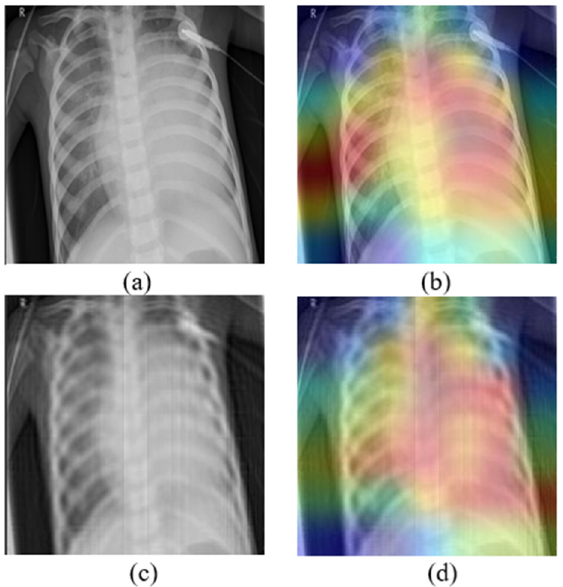
Figure 4. ( a ) Original image, ( b ) the corresponding GradCAM, ( c ) image under Mb-AdA with order 60, and ( d ) the corresponding GradCAM .